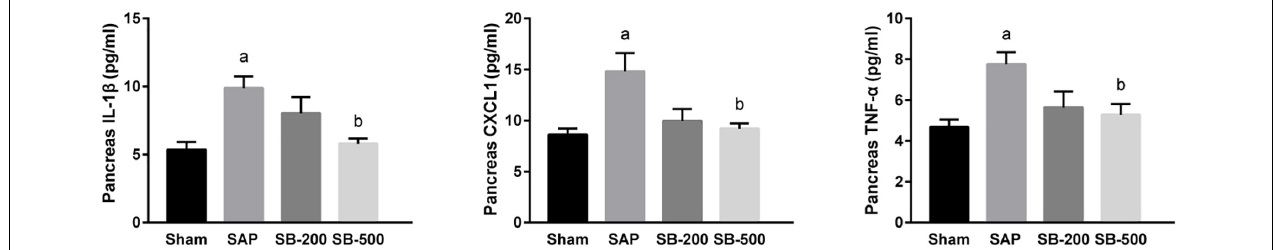
FIGURE 2 | The concentration of IL-1 β , CXCL1, and TNF- α in the pancreas of mice in each group. n = 8. The data were presented as the mean ± standard error of the mean. p < 0.05 vs. Sham group. Sham, Sham operation group; AP, acute pancreatitis group; SB-200, 200 mg/kg butyric acid intervention group; SB-500,